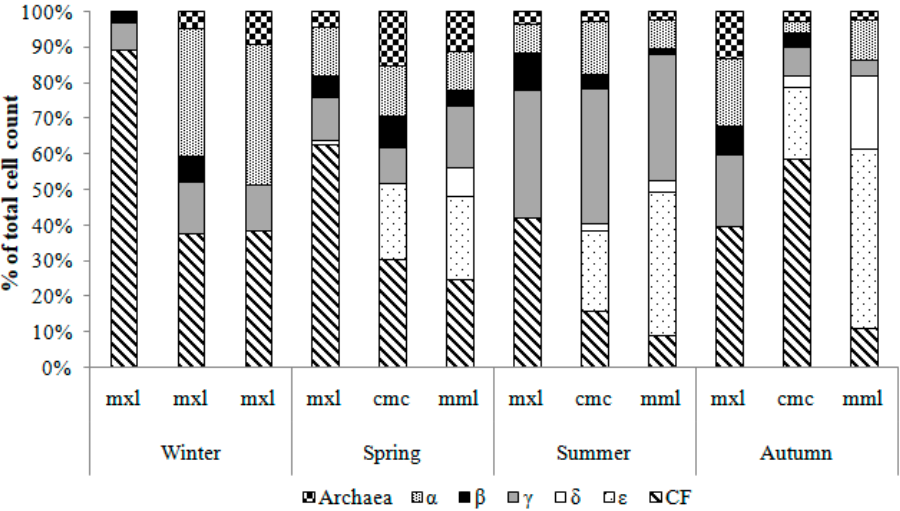
Figure 4. Relative amounts of DAPI-stained bacteria detected by CARD-FISH of major bacterial clades, during a one year-long observation according to the season (mxl: mixolimnion; cmc: chemocline; mml: monimolimnion).